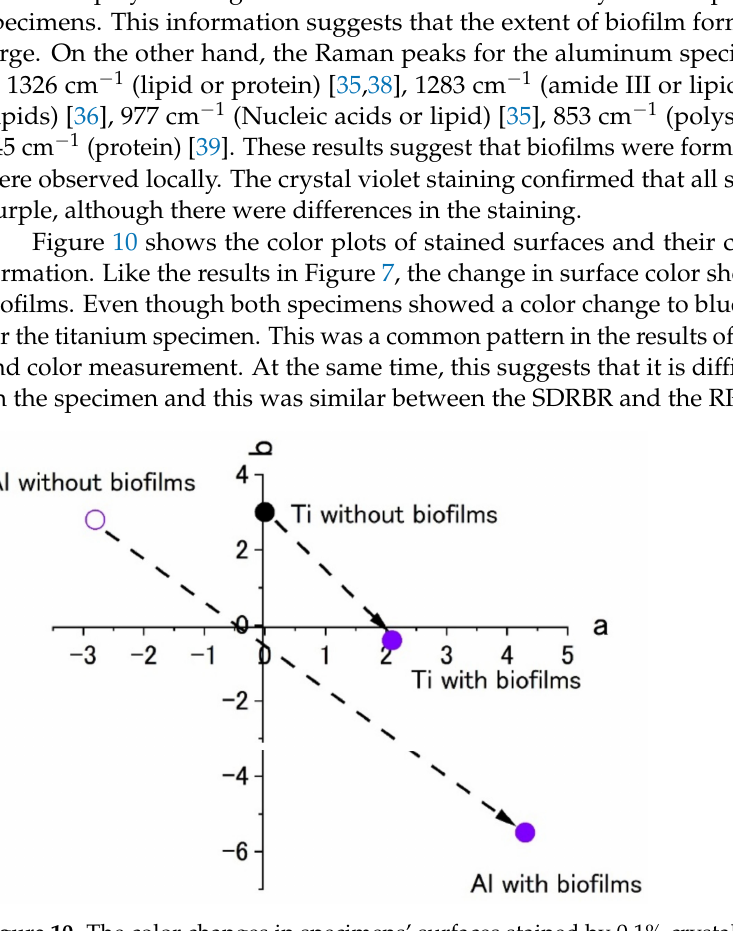
Figure 10. The color changes in specimens’ surfaces stained by 0.1% crystal violet in the RPDLBR. (a) complementary color dimension between red and green. (b) complementary color dimension between yellow and